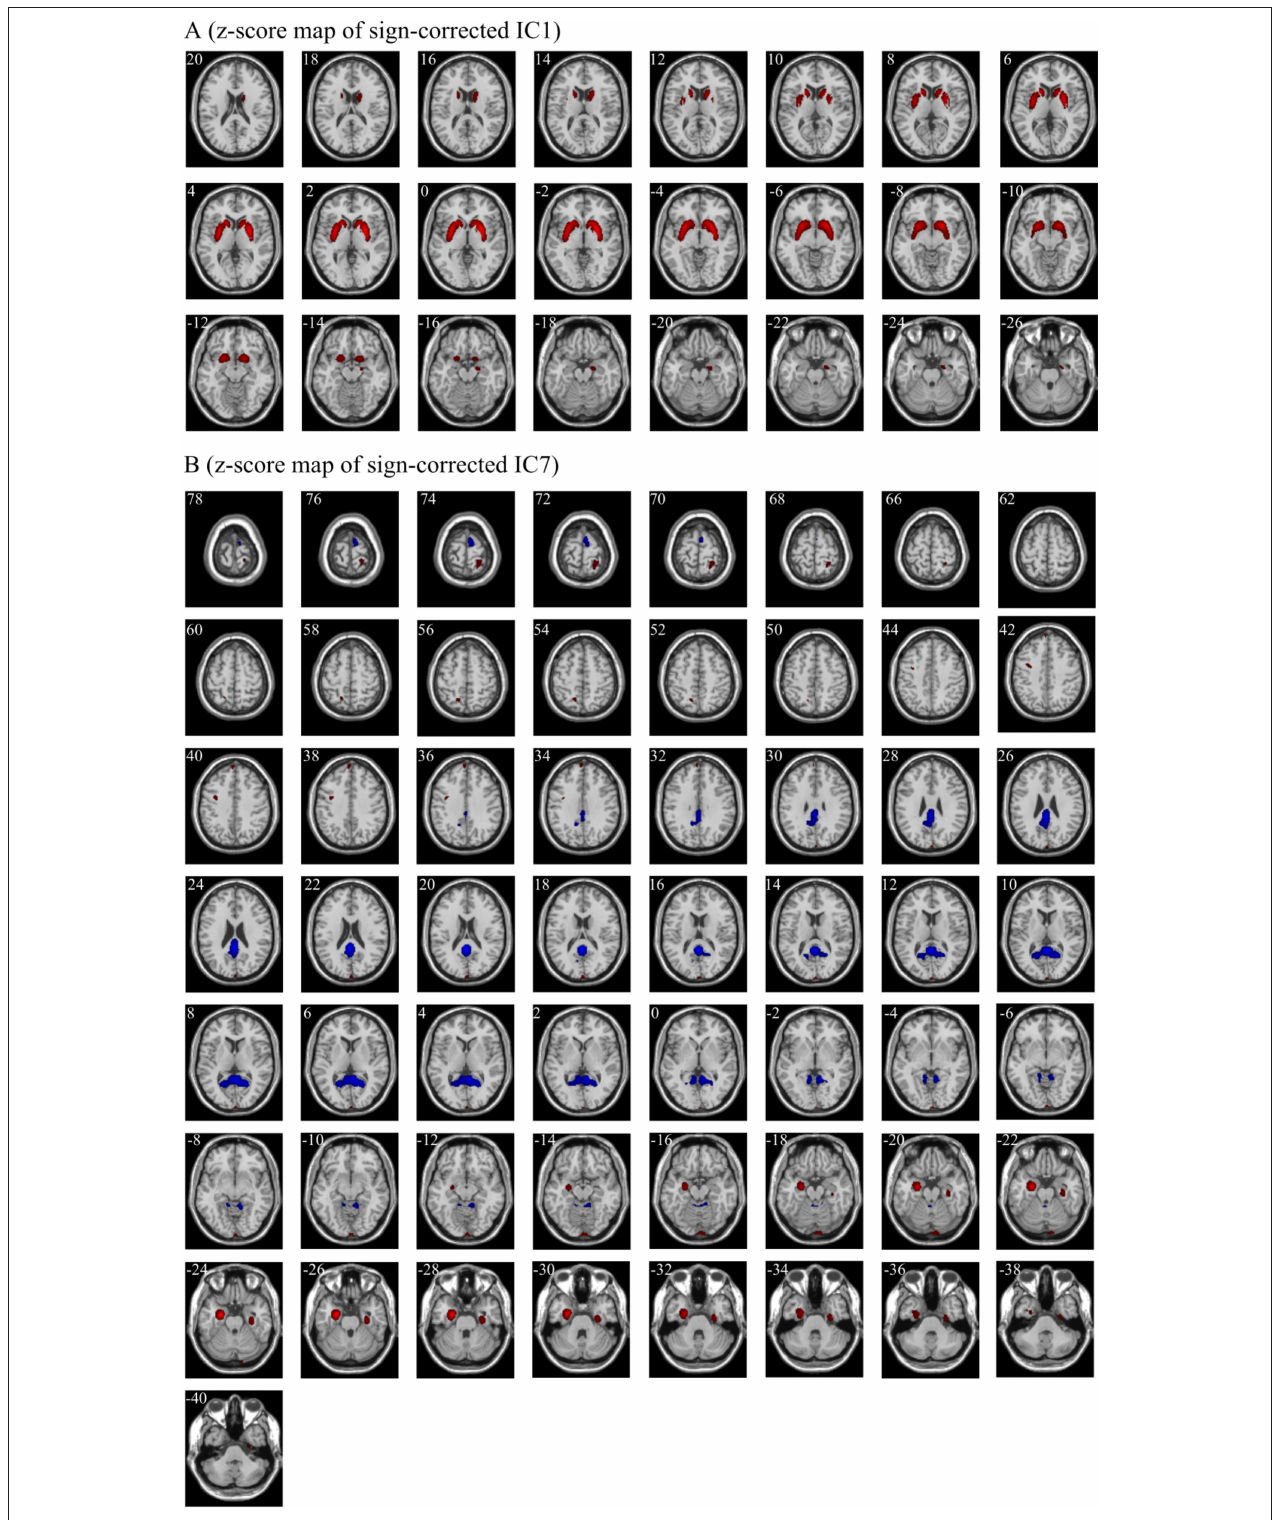
FIGURE 4 | The significant regions in the z-score maps of sign-corrected IC1 (A) and sign-corrected IC7 (B) (|z| > 2.58, p < 0.01, cluster extent ≥ 50 voxels). Red indicates the regions with a z value > 2.58 and a cluster extent ≥ 50 voxels, and blue indicates the regions with a z value < − 2.58 and a cluster extent ≥ 50 voxels. The positively significant regions (red) and the negatively significant regions (blue) indicate hypermetabolism and hypometabolism in patients with anti-LGI1 encephalitis, respectively. The white number in the upper left of each sub-figure indicates the Montreal Neurological Institute coordinates of transversal slices. R/L, right/left.